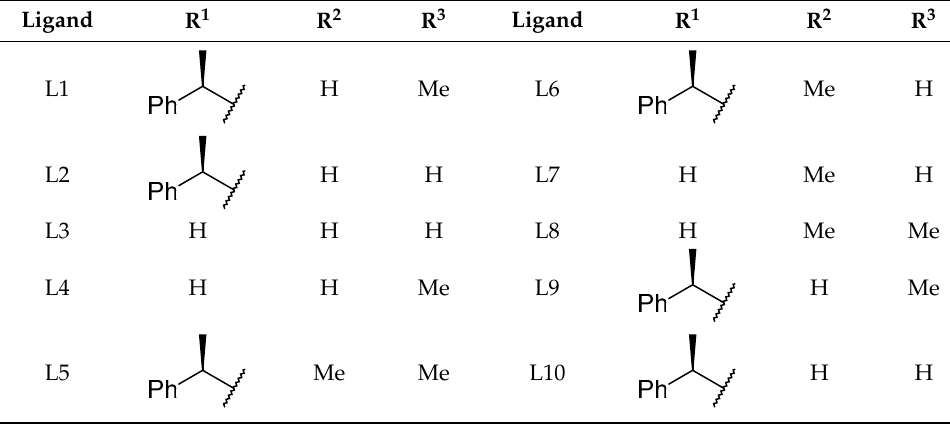
Table 1. Ligands studied at pharmacophore study.